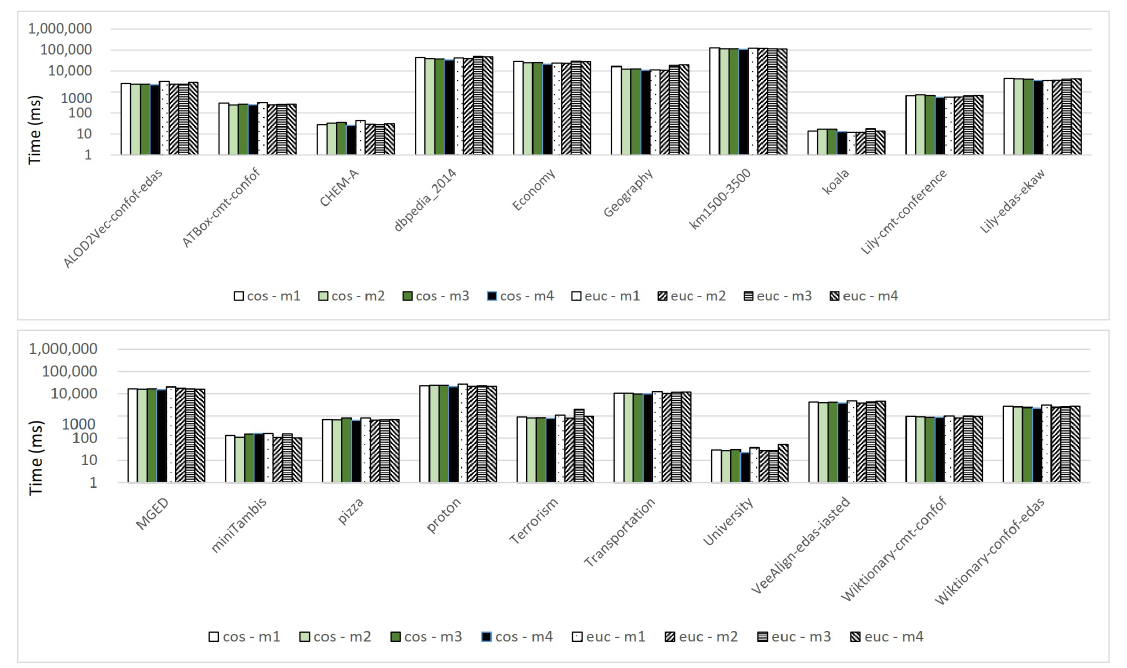
Figure 5. Time in milliseconds (y-axis) for each incoherent ontology to compute a diagnosis by the threshold-based algorithm with different models and distance metrics while keeping the same threshold of 0.5.